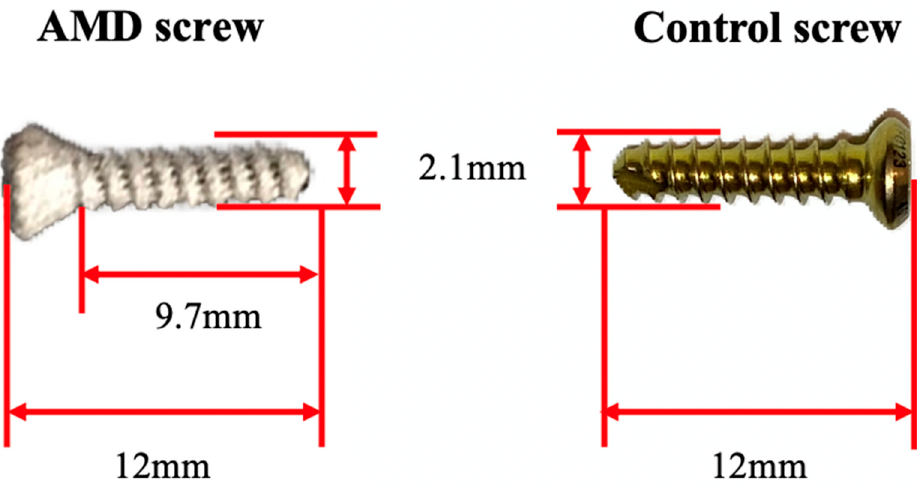
Figure 8. Illustration of a porous AMD screw. The control interference screw was made with Ti and had a screw body length of 12 mm, core diameter of 1.8 mm, thread diameter of 2.1 mm, head diameter of 2.4 mm, and pitch of 1.0 mm (Depuy Synthes, Johnson and Johnson, New Brunswick, NJ, USA). The AMD screw with a similar morphology was produced using an EOSINT M 280 laser sintering system (EOS GmbH, Munich, Germany). The AMD interference screws received NaOH and heat treatments for bioactive ceramic surface modification.